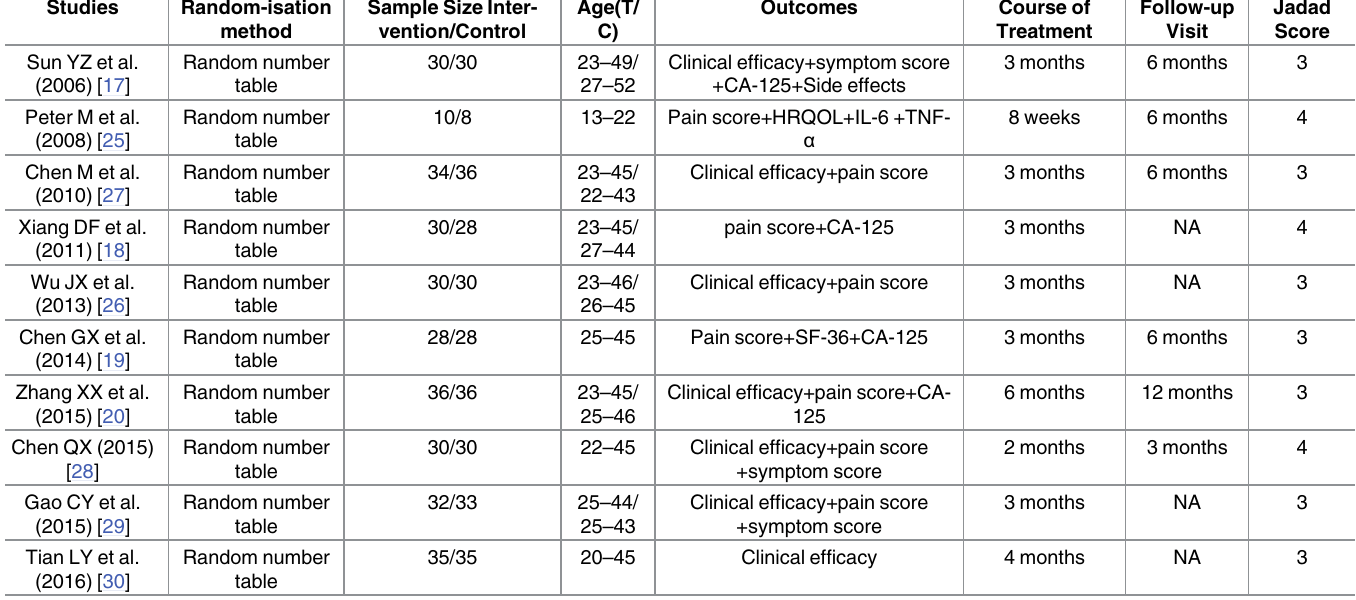
Table 1. Characteristics of the 10 trials identified in the literature search.